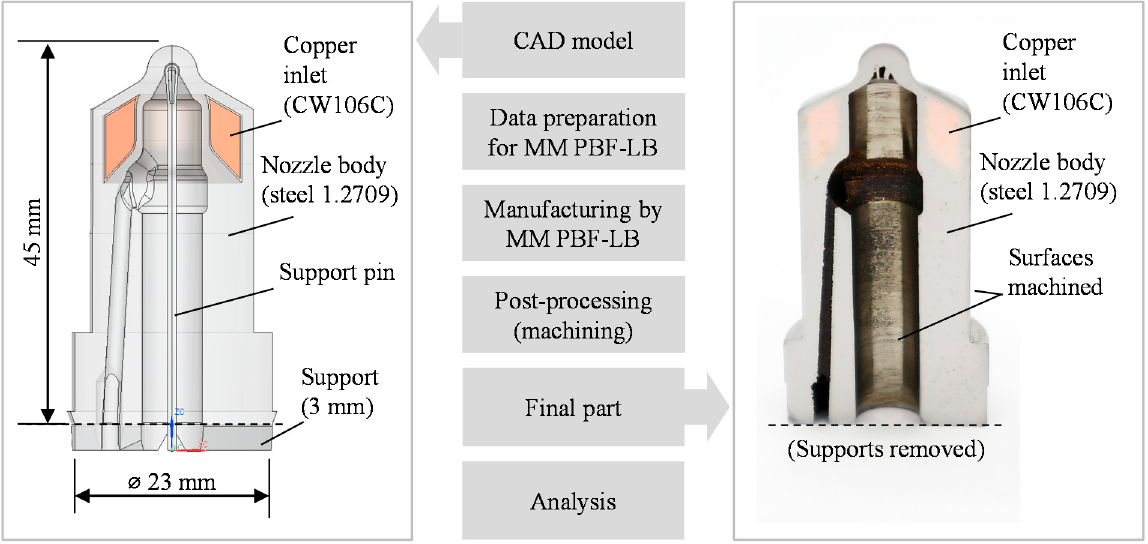
Figure 3. Process chain to manufacture the MM injection nozzle.